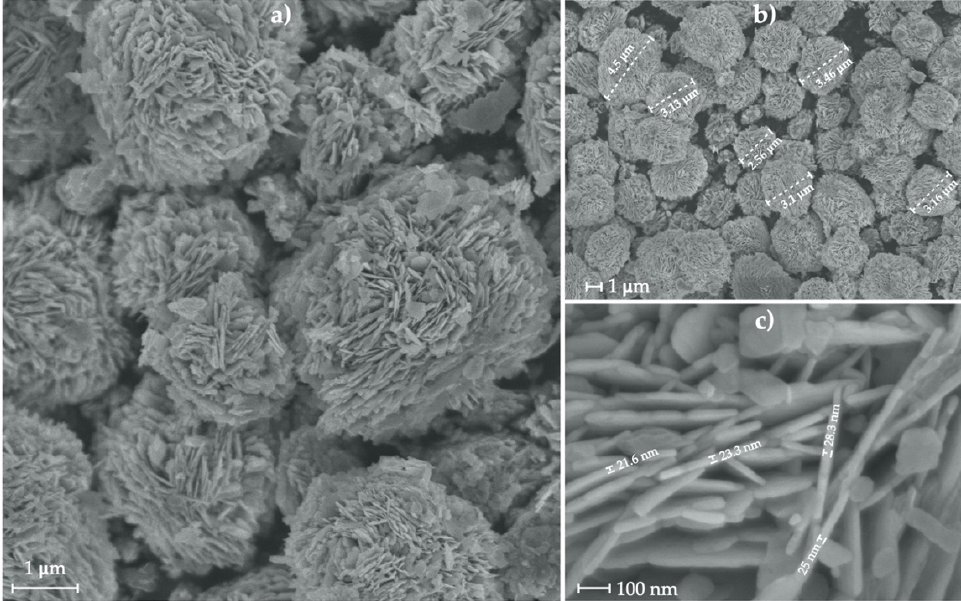
Figure 2 . SEM image of ZnO MSs ( a , b ) and their two-dimensional nanosheets ( c ). Figure 2. SEM image of ZnO MSs ( a , b ) and their two-dimensional nanosheets ( c ). SEM images of ZnO MS with 1.9 and 9.8 mM of precursor concentration during dif- SEM images of ZnO MS with 1.9 and 9.8 mM of precursor concentration ferent UV irradiation times (5, 15, and 30 min) can be seen in Figure 3. Once again, micro-